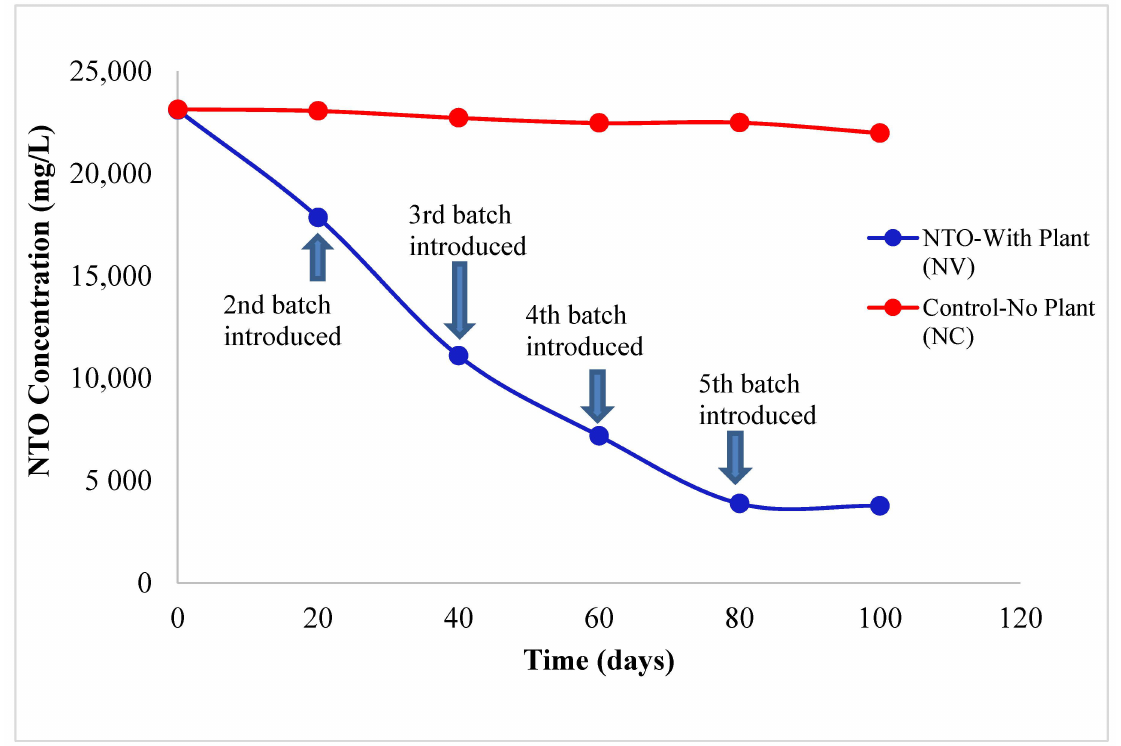
Figure 1. Change in 3-nitro-1,2,4-triazol-5-one (NTO) concentration in NTO-wastewater during the 100 d experiment. New batches of vetiver plants were introduced in NTO with plant (NV) treatments every 20 days. In control experiments (NC), containers of NTO were maintained without vetiver plants. At the end of the 100-day study, the average NTO concentration was reduced by 83.68 ± 0.43% ( ± SD) of its initial concentration in NV treatments, whereas only 5.0 ± 1.3% ( ± SD) NTO reduction was estimated in NC